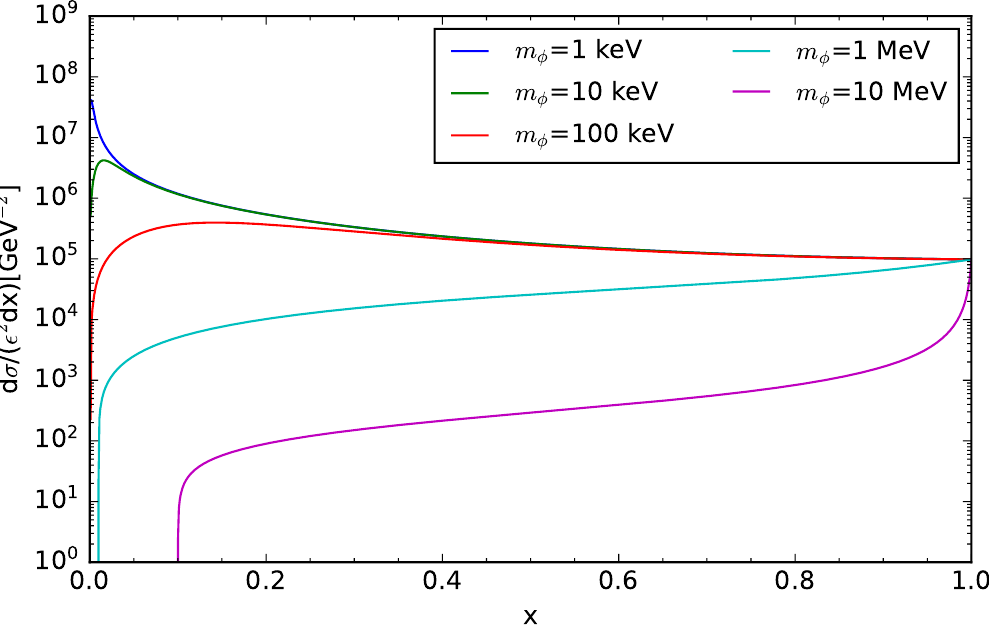
Figure 6 . The generalized IWW differential cross-sections for DP production for a 100 MeV e − beam on a tungsten target for several different DP masses. Here x is the fraction of DP energy relative to that of the e − beam energy. Note that here the differential cross-section is scaled by 1 /(cid:15) 2